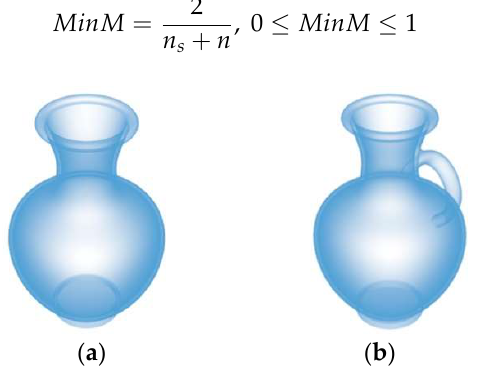
Figure 2. Vertical symmetry of an object; ( a ) Higher minimalism; ( b ) Lower minimalism .